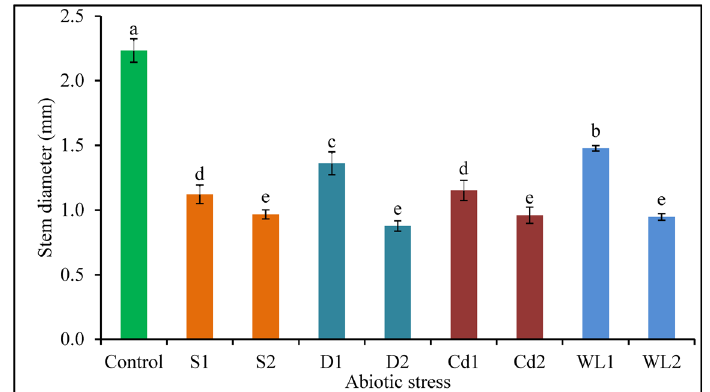
Figure 4: Stem diameter of C. olitorius plants a ff ected by di ff erent abiotic stresses. S 1 , S 2 , D 1 , D 2 , Cd 1 , Cd 2 , WL 1 , and WL 2 represent 200 mM of NaCl, 400 mM of NaCl, 10 days of water de fi cit, 15 days of water de fi cit, 2 mM of CdCl 2 , 4 mM of CdCl 2 , 5 days of waterlogging, and 15 days of waterlogging, respectively. Mean value (± SD ) was calculated from three replicates for each treatment. Values in a column with di ff erent letters are signi fi cantly di ff erent at p ≤ 0.05 applying LSD test.